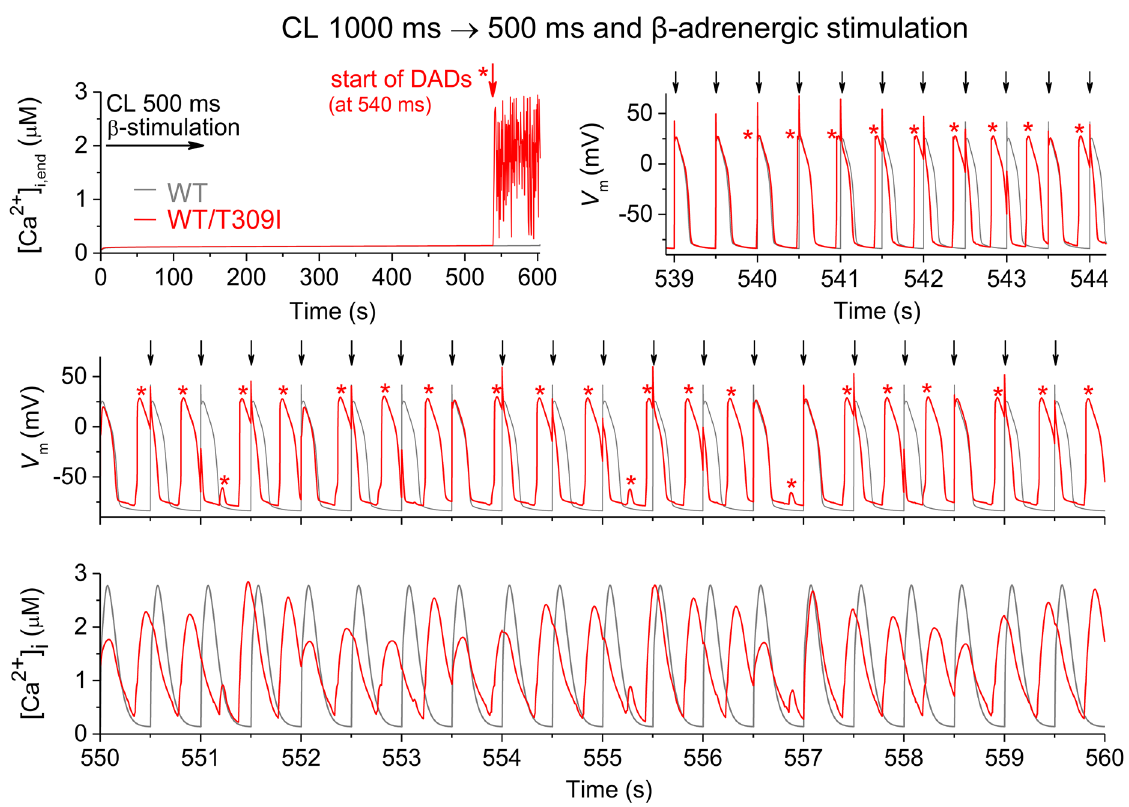
Figure 1. A correct version of the original Figure 5c.